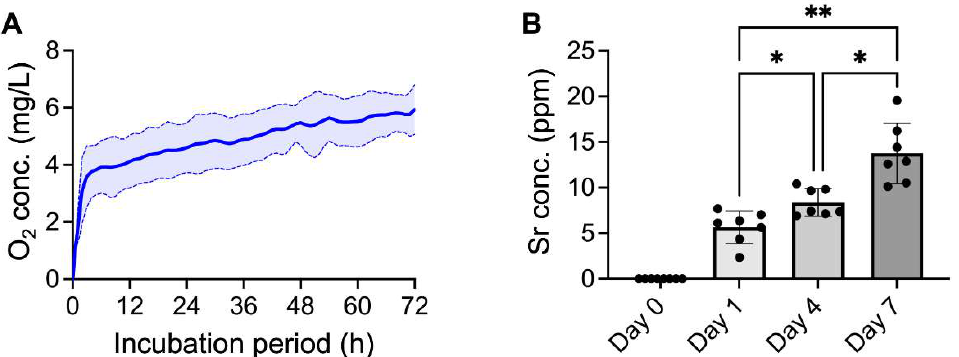
Figure 2. SrO 2 + MnO 2 @PLGA/gelatin scaffolds release oxygen and strontium ions. The release kinetics of ( A ) oxygen ( n = 4) and ( B ) strontium ( n = 7) from the SrO 2 + MnO 2 @PLGA/gelatin scaffolds incubated in PBS. * p < 0.05; ** p < 0.01. Data are the mean ± s.d.